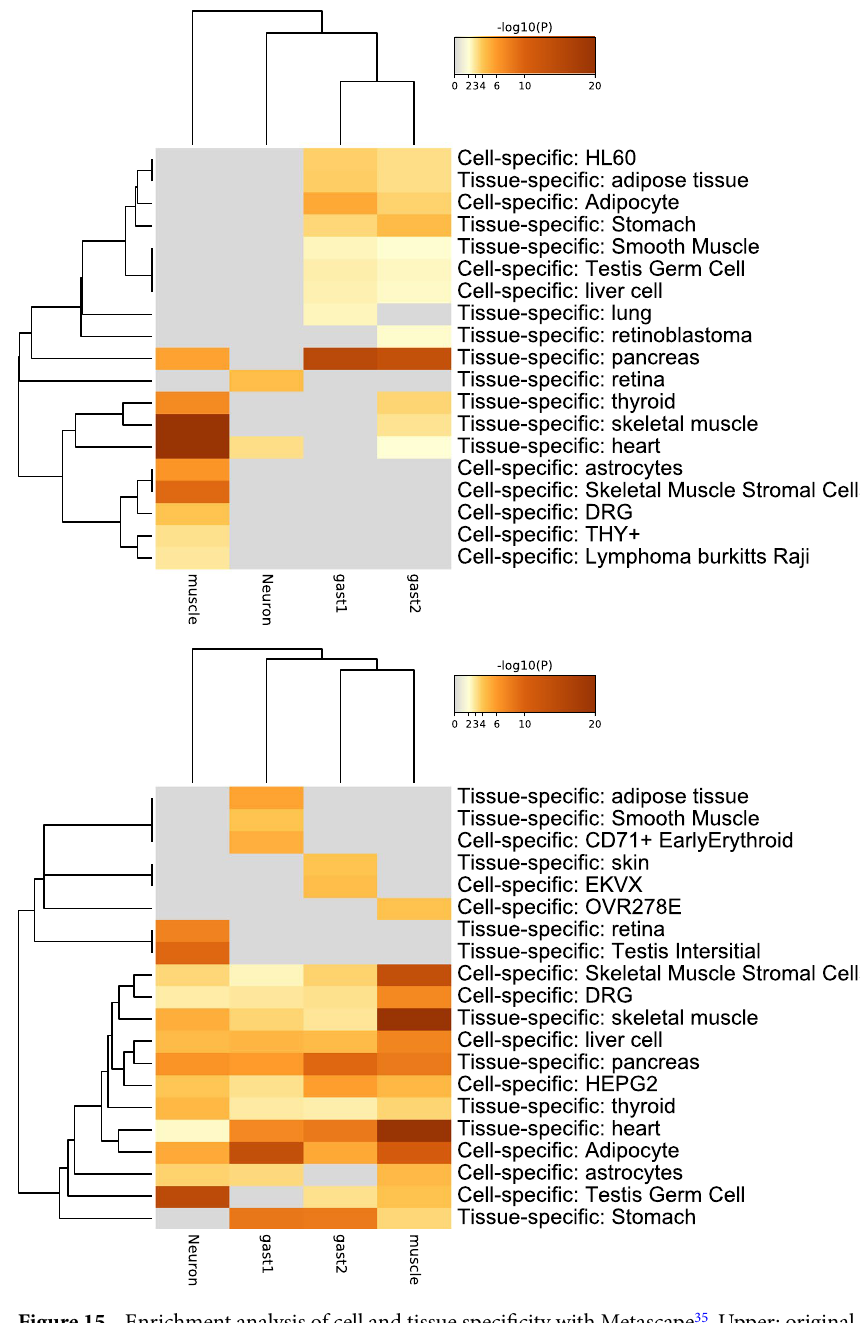
Figure 15. Enrichment analysis of cell and tissue specificity with Metascape 35 . Upper: original TD-based unsupervised FE (using genes with adjusted P ≤ 0.01 in Table 8), lower; the present study with optimized SD (using genes with adjusted P ≤ 0.1 in Table 8). Metascape 3.5, https:// metas cape.